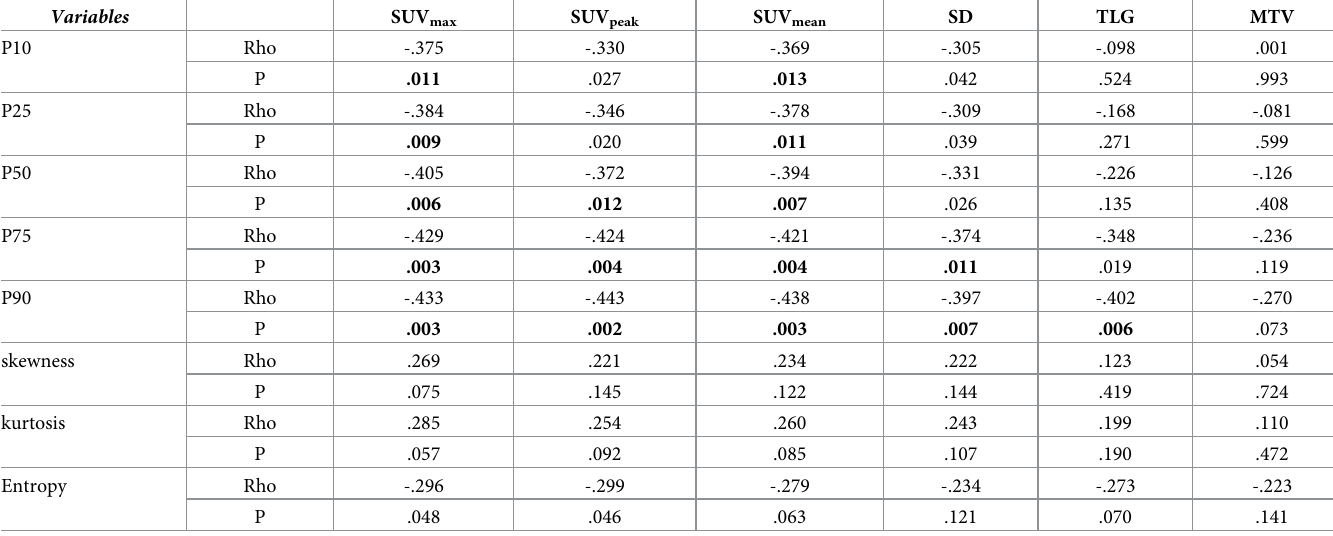
Table 4. Results of Spearman’s correlation tests between K trans and 18 F-FDG-PET parameters in lymph nodes (N = 45).